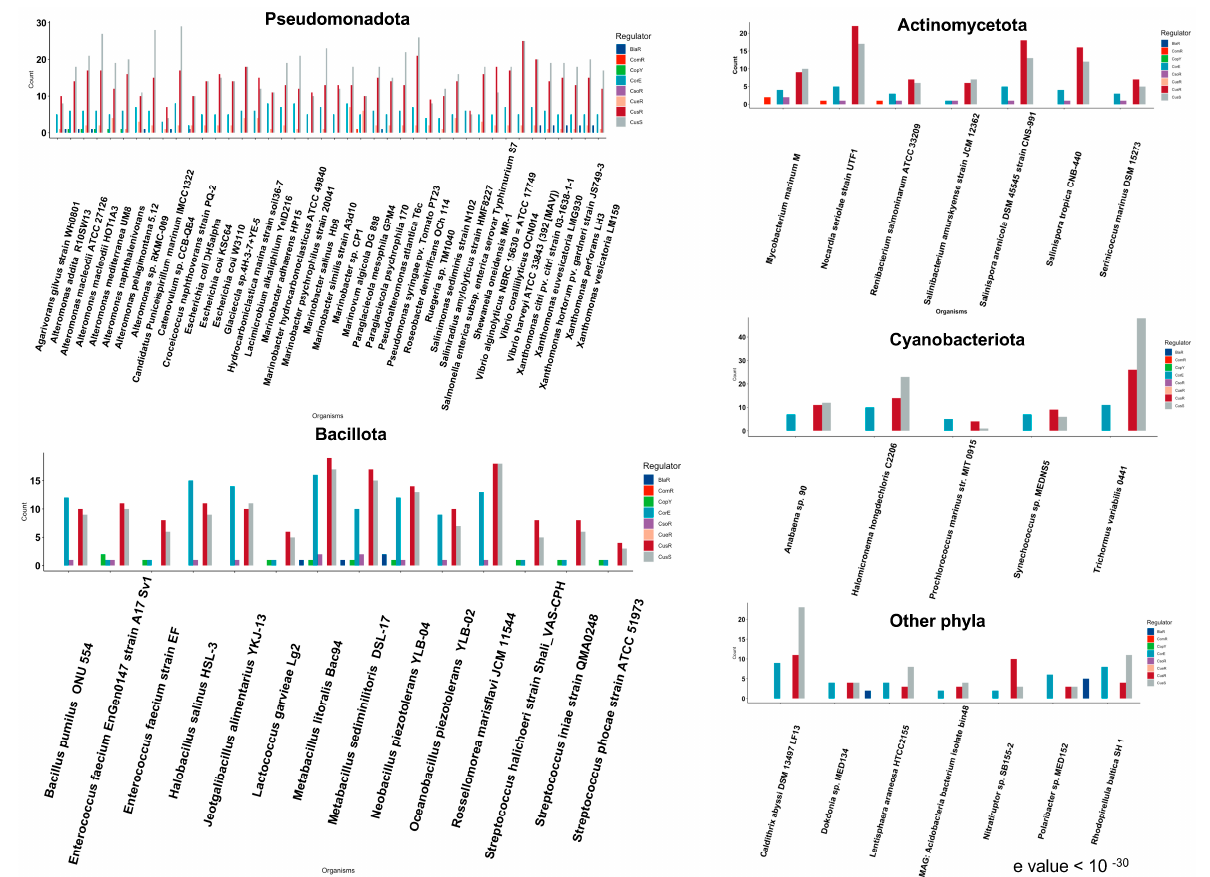
Figure 3. Number of hits to copper-associated signal transduction system in marine bacteria based on phylogeny. The copper-associated system homolog hit count was plotted against each bacterial strain, and each bar color represents a different regulatory system. Panels represent the phyla used.